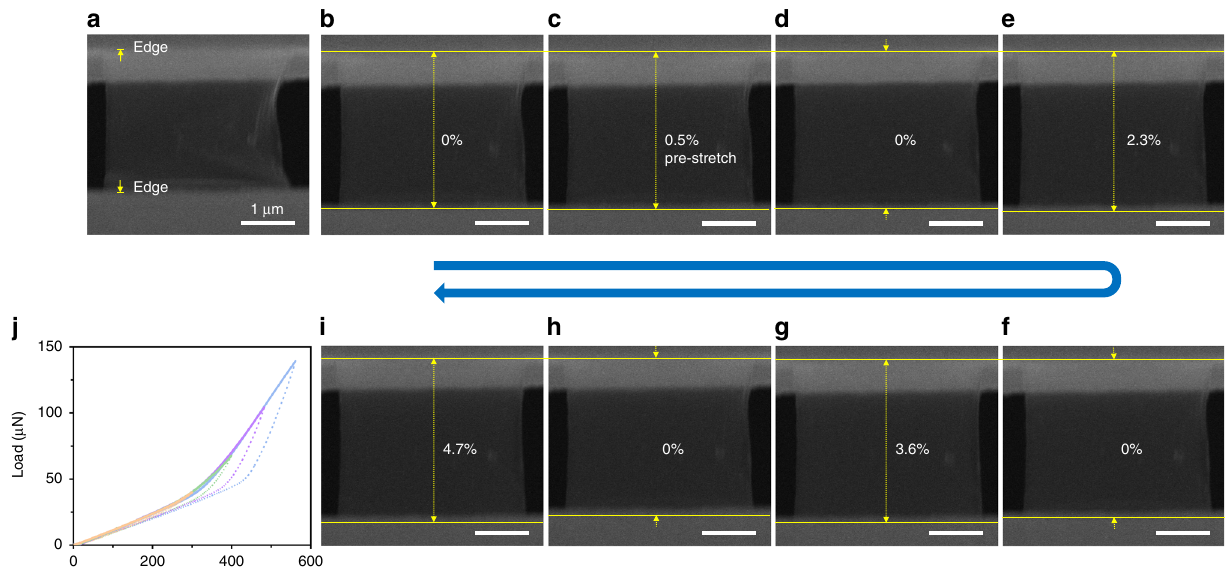
Fig. 2 Fully recoverable elastic straining of a suspended graphene monolayer. a – i The sequence SEM images of the recorded video during the tensile testing procedure with the largest indentation displacement of 300 nm a – c , 400 nm d – e , 500 nm f – g , 600 nm h – i . The yellow arrows in a indicate the edges of the PTP device gap (tilted view). The fi rst cycle b – c was to pre-stretch the relaxed free-standing single-crystalline graphene sample for marking the initial gauge length. The scale bar in all images are 1 μ m. j The corresponding indenter load-displacement curves for cyclic elastic straining of the free- standing graphene (with unloading part marked in dash